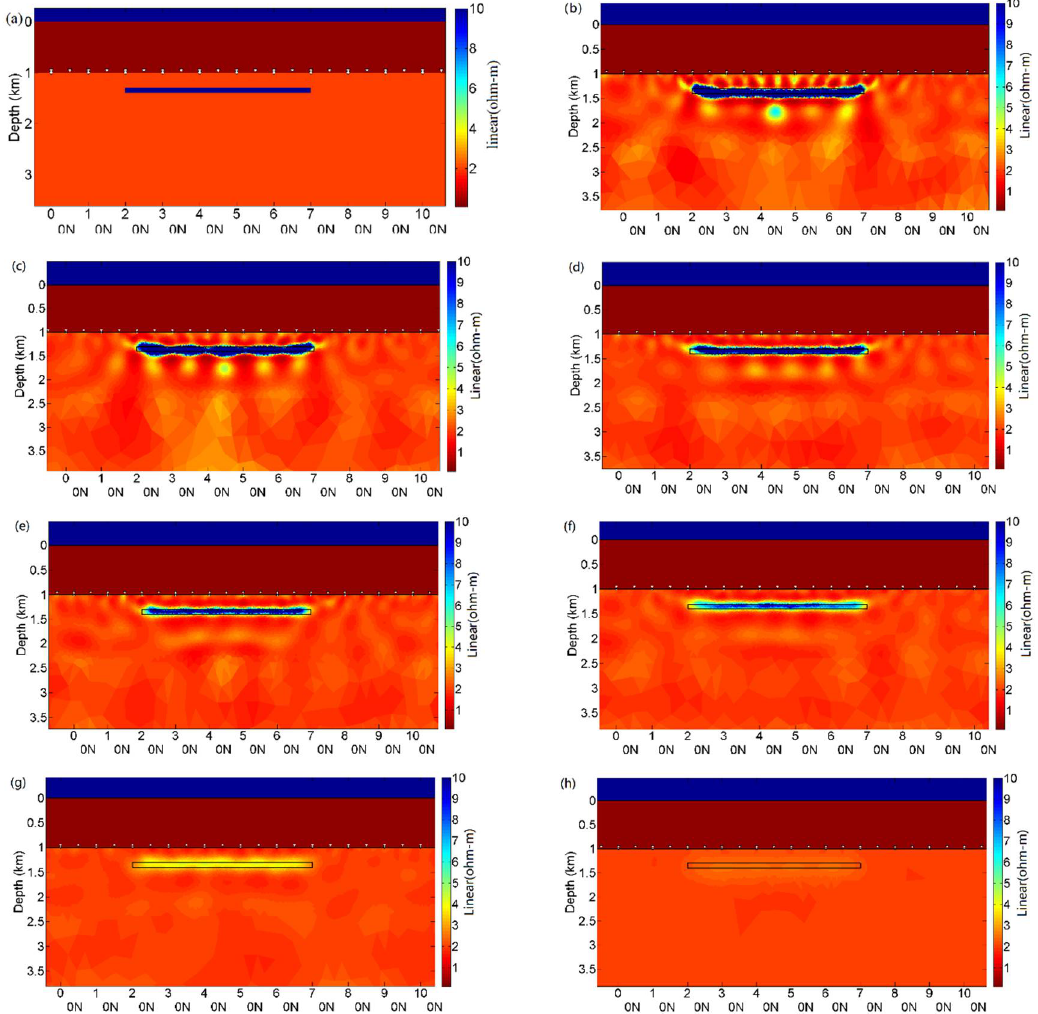
Figure 1. Initial model and inversion results of different values of TR. (Change resistivity of targets) ( a ) initial model; ( b ) TR: 10,000 Ω·m 2 ; ( c ) TR: 5000 Ω·m 2 ; ( d ) TR: 2000 Ω·m 2 ; ( e ) TR: 1000 Ω·m 2 ; ( f ) TR: 800 Ω·m 2 ; ( g ) TR: 400 Ω·m 2 ; ( h ) TR: 300 Ω·m 2 .